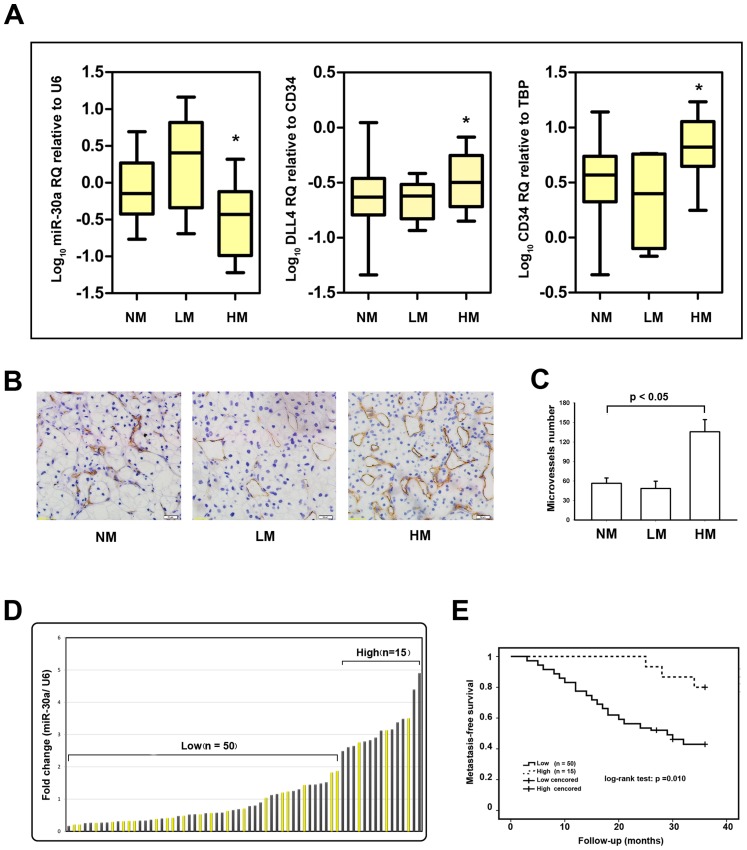
Association of miR-30a with ccRCC hematogenous metastasis and metastasis-free survival.(A) Real-time PCR analyses of miR-30a expression (left panel), DLL4 density (middle panel), and MVD (right panel) in non–metastatic (NM; n = 65), lymphatic metastatic (n = 6) and hematogenous metastatic (HM; n = 19) ccRCC. *p<0.05 based on a comparison between the HM and NM groups. Each box represents the median and 75th and 25th percentile values, and the bars represent minimums and maximums. (B) CD34 staining MVD in ccRCC including NM, LM, HM. (C) Statistical result of MVD in the three groups. (D) A total of 65 cases of non-metastatic RCC were grouped into two, “low miR-30a” (n = 50) and “high miR-30a” (n = 15) according to miR-30a expression at the threshold giving the lowest p value of log-rank test comparing metastasis-free survival between the two groups. (E) Kaplan-Meier graph representing the probability of metastasis-free survival in ccRCC from the two groups. The status was defined as “occurred metastasis or not”, “High” referred to “High-level of miR-30a expression”, while “Low” referred to “Low-level of miR-30a expression”. Log-rank test was used to estimate and compare the probability of metastasis-free survival of the two groups. The p value was from a log-rank test.